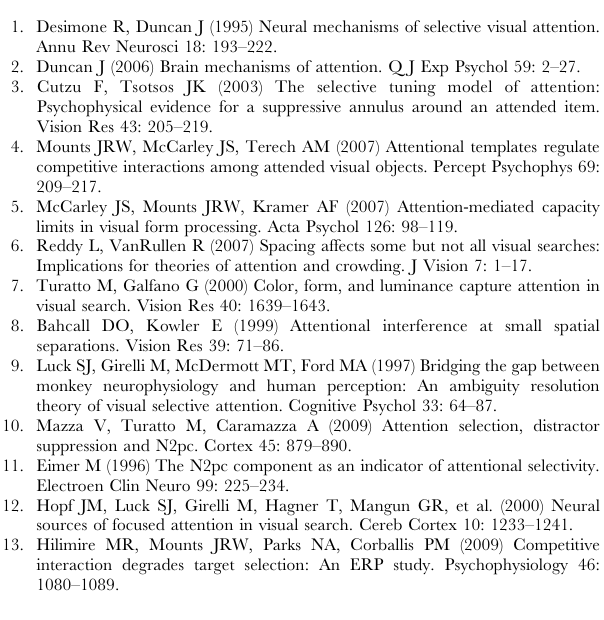
Figure 7. Difference waveforms and scalp distributions from Experiment 2. (a) Left: Ipsilateral/contralateral difference waveforms at electrodes PO3/4 for Experiment 2. These were calculated by subtracting the ipsilateral waveforms from the contralteral waveforms plotted in Figure 6. These difference waveforms allow N2pc and Ptc amplitudes to be compared across levels of target-decoy separation and relative salience. Right: N2pc and Ptc amplitudes as a function of target-decoy separation and relative salience. Note that N2pc amplitude increases with increasing target-decoy separation and N2pc amplitude increases when the decoy is relatively more salient than the target. Ptc amplitude is more positive when the target and decoy are near each other and did not vary with the relative salience manipulation. Error bars are standard error. (b) Scalp distribution of the N2pc. (c) Scalp distribution of the Ptc.